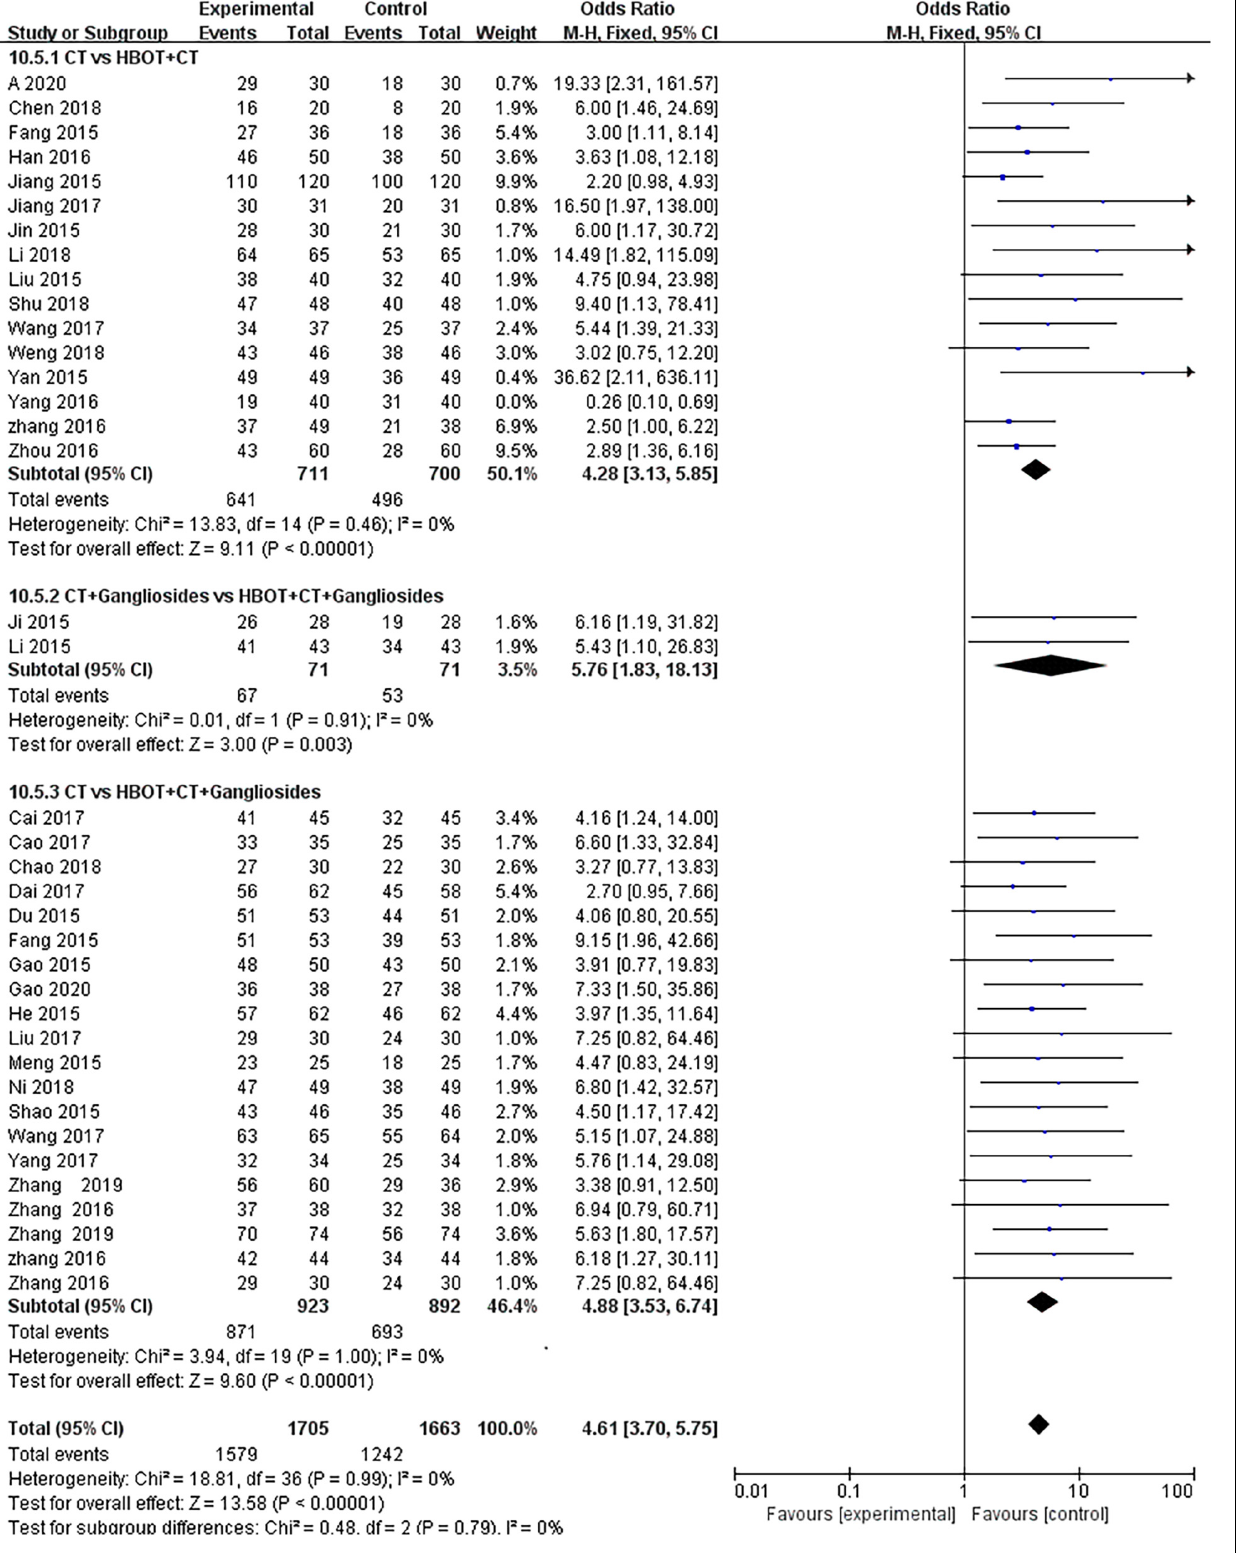
Frontiers in Pediatrics |